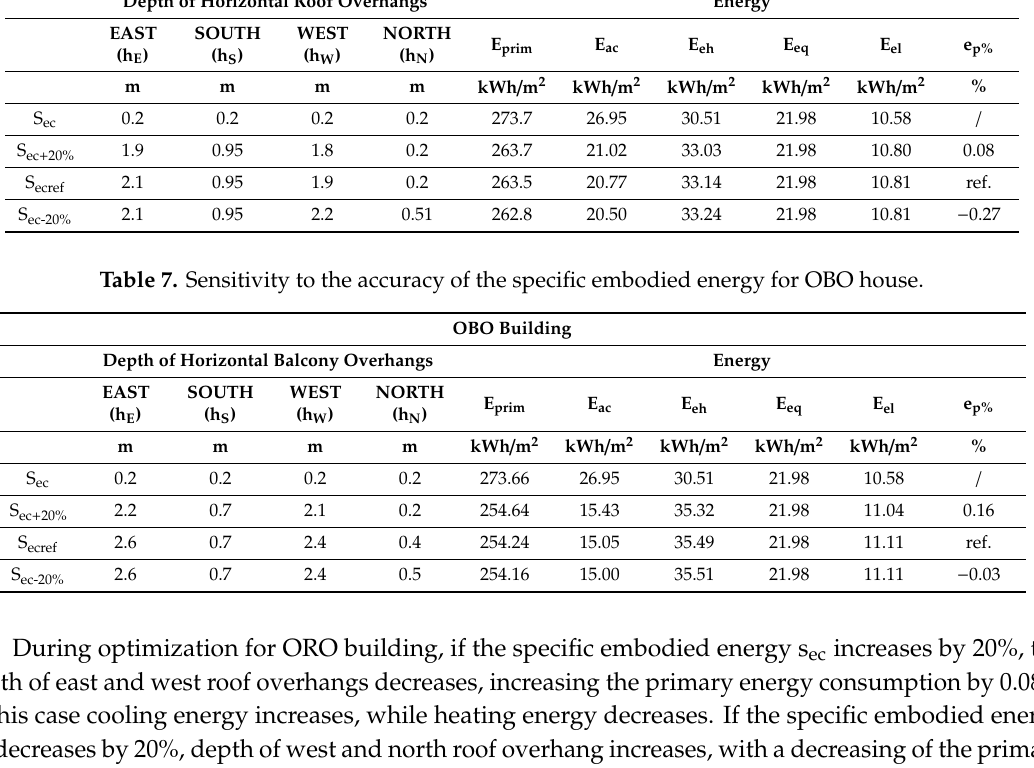
Table 6. Sensitivity to the accuracy of the specific embodied energy for ORO house. ORO Building